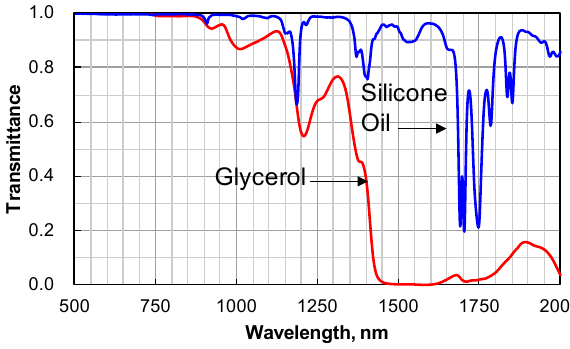
Figure 3. Transmission spectra of glycerol and silicone oil with 2.3-mm